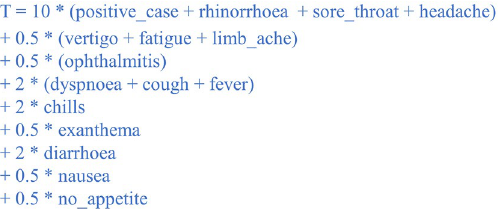
Figure 1. Algorithm used to increase the likelihood of including positive cases in pools for testing by computing a priority score based on the variables collected in the Initial (Q1) and Pre-test Questionnaires (Q2). Each variable was set to 1 if true and 0 if false. The threshold (T) was set to reflect local infection incidence levels, such that no more than 5 pupils were selected for each test